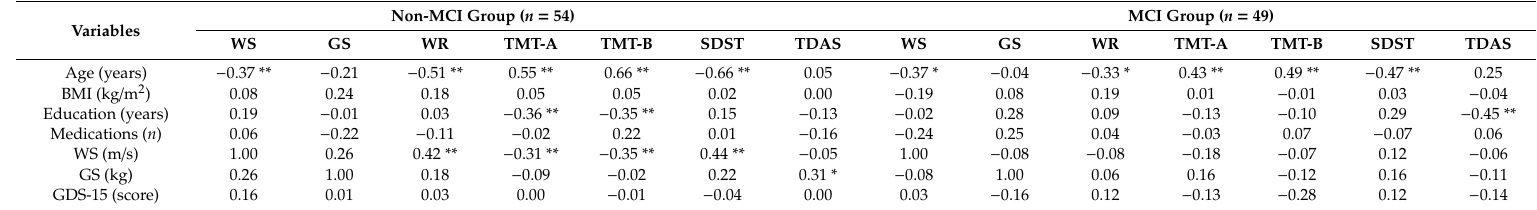
Table 2. Correlations for each group (non-MCI and